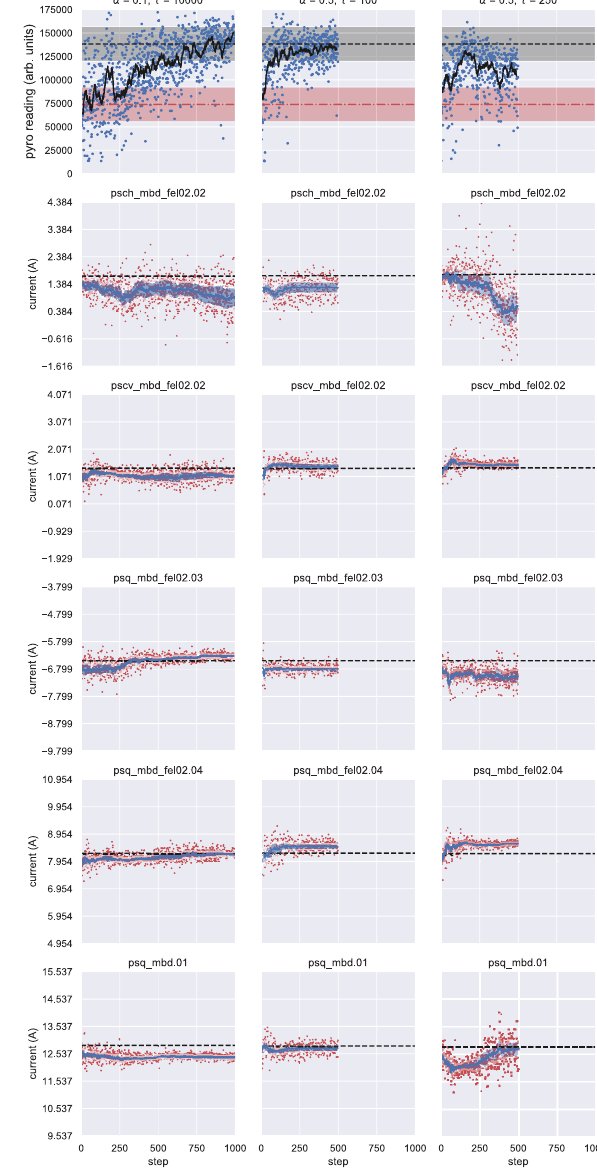
FIG. 8. Optimization runs for TeraFERMI. Each column represents a different run with the parameters given at the top of the column. The top row of plots shows the signal of the TeraFERMI pyro, while the remaining rows show the setting of the various magnets used for optimization. In the top row, the blue dots are the readings at each step; the black solid line is a rolling 20 point average of the readings; the black dashed line is the mean signal strength found by an operator with the surrounding shaded region showing the standard deviation of that measure- ment; and the red dash-dot line is the mean signal strength of the initial setting of the magnets after detuning with the surrounding shaded region showing the standard deviation of that measure- ment. In the remaining plots, the red dots are the magnet setting for each step; the blue line is the mean of the policy distribution; the shaded blue region is the standard deviation of the policy; and the black dashed line is the magnet setting found by the operator. 1000 steps takes approximately 1